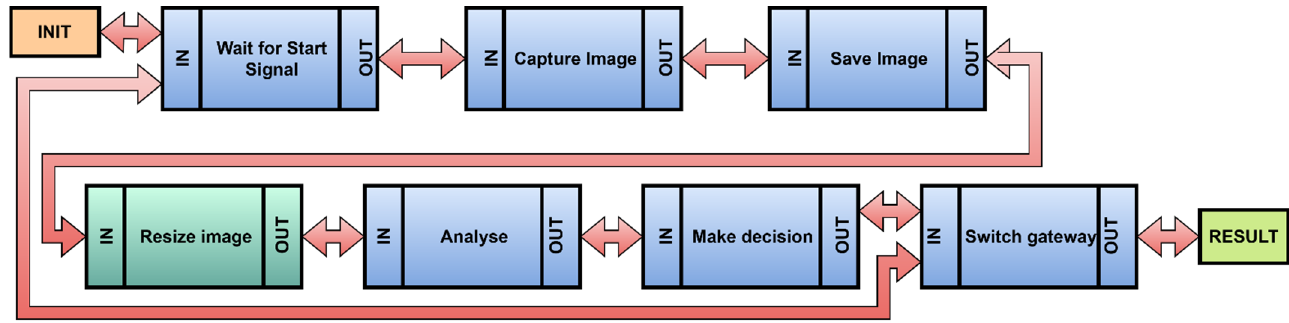
Figure 21. Missing steps added into workflow.